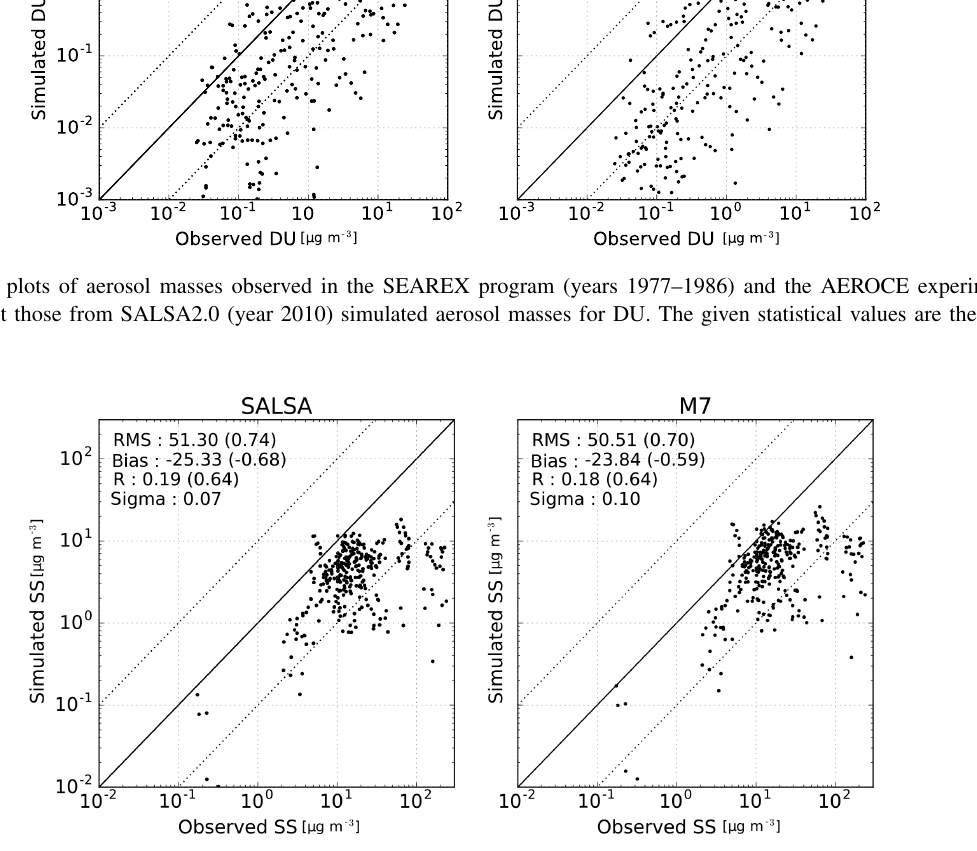
Figure 11. Scatter plots of aerosol masses observed in the SEAREX program (years 1977–1986) and the AEROCE experiment (years 1990–1995) against those from SALSA2.0 simulated aerosol masses for SS. The given statistical values are the same as in Fig.